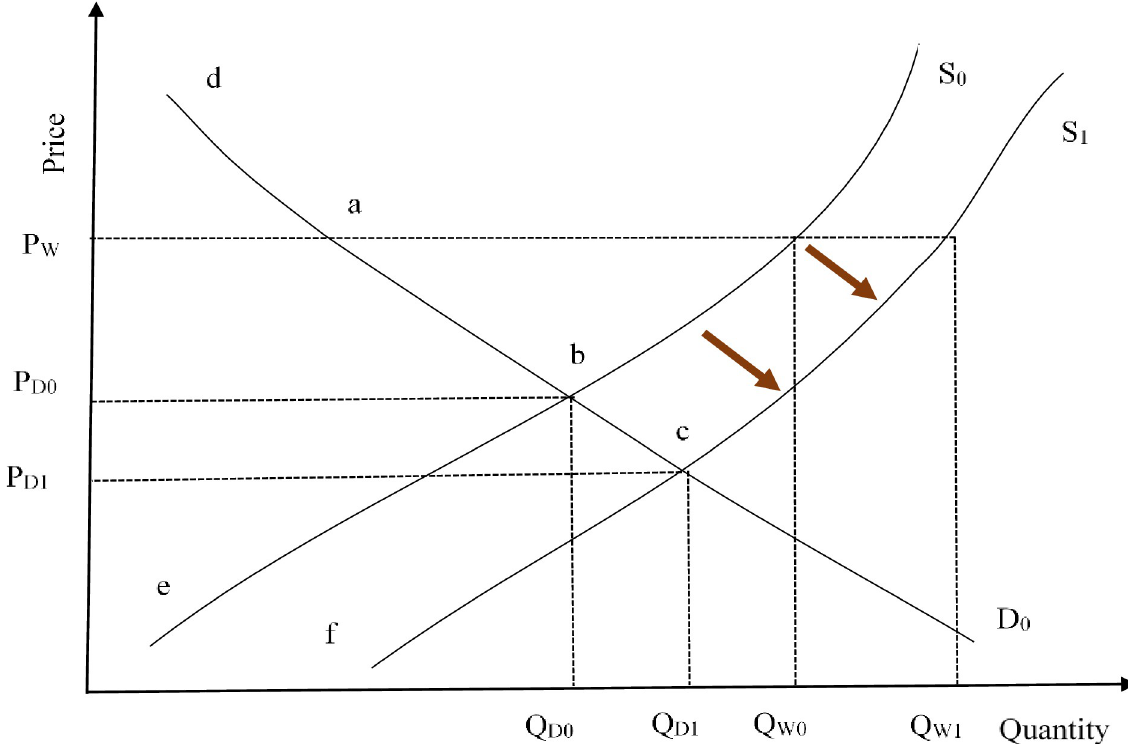
Fig 1. A conceptualization of induced supply shift due to integrated pest and pollinator management intervention in a small open economy. Source: Adapted from [27].